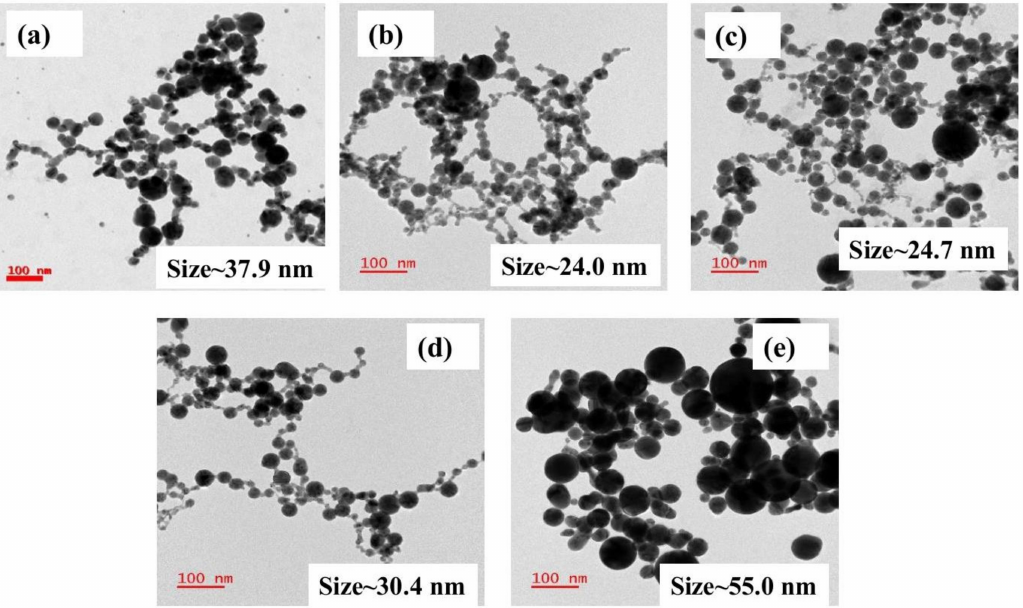
Figure 2. TEM images of as-fabricated NPs by laser ablation ( a ) Ag NPs ( b ) Ag 70 Au 30 NPs ( c ) Ag 50 Au 50 NPs ( d ) Ag 30 Au 70 NPs ( e ) Au NPs,